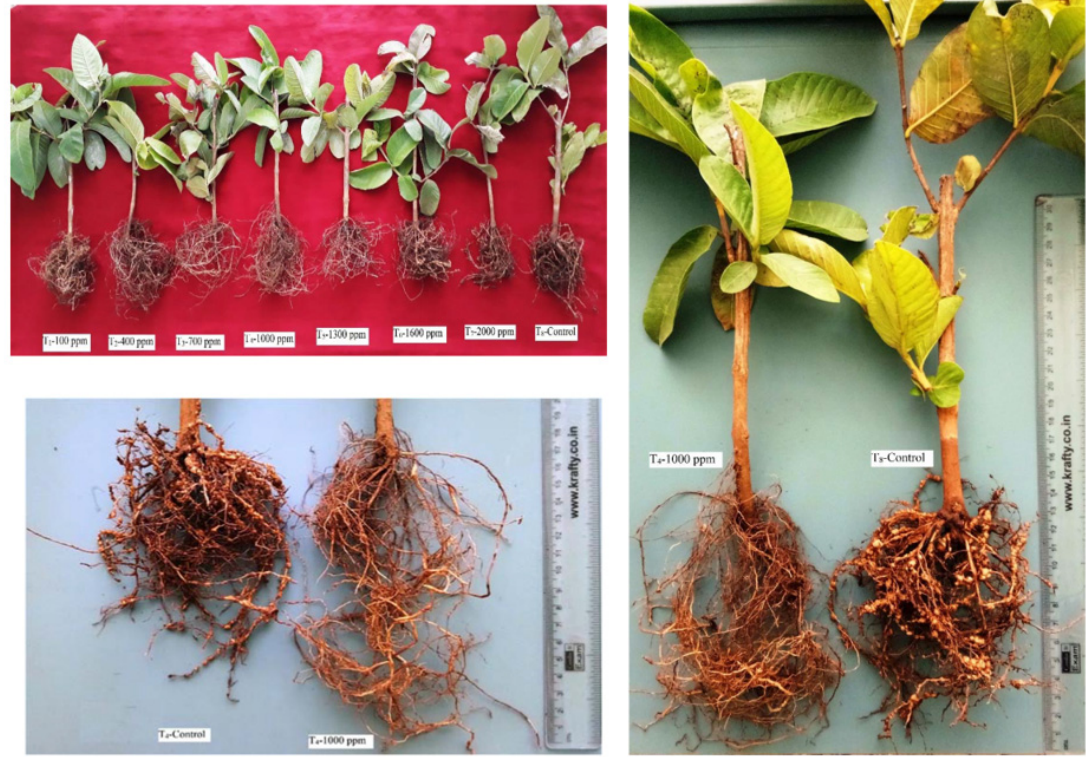
Figure 1. Effects of indole 3-butyric acid (IBA) on root knot nematode, M. enterolobii, in guava plants.